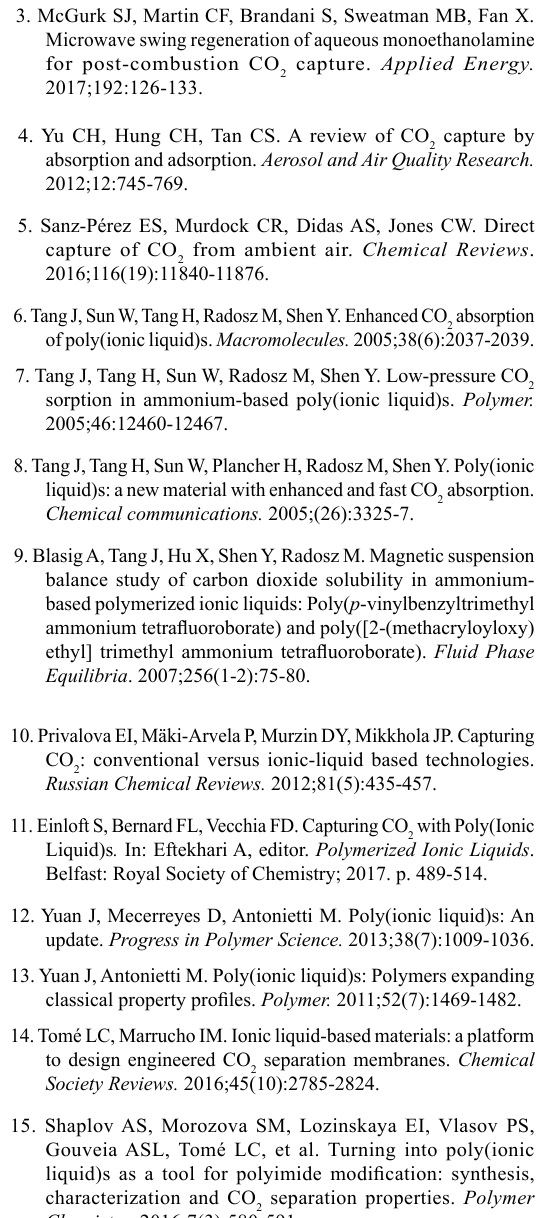
Figure 11. PU/CPIL-TBP 10% CO